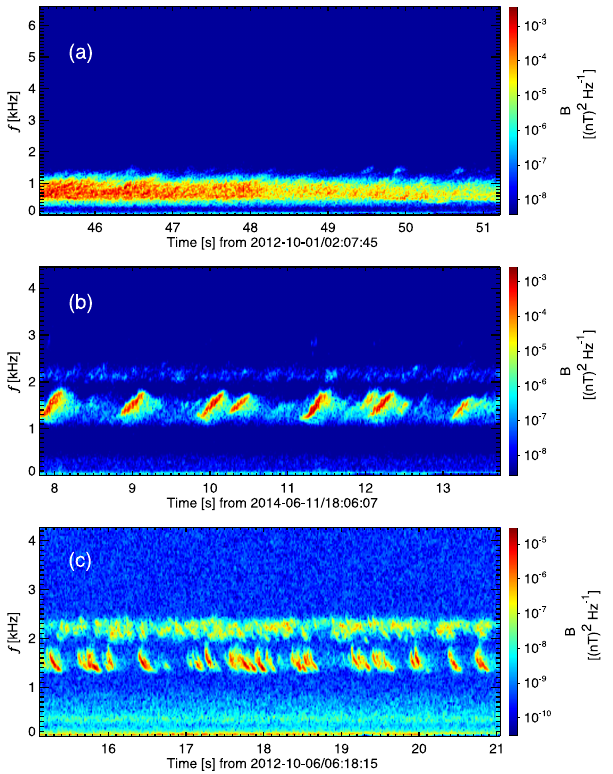
Figure 1. Three typical spectrograms of whistler mode electromag- netic emissions with frequency below the electron cyclotron fre- quency: (a) broadband whistler mode waves, (b) rising-tone chorus, and (c) falling-tone